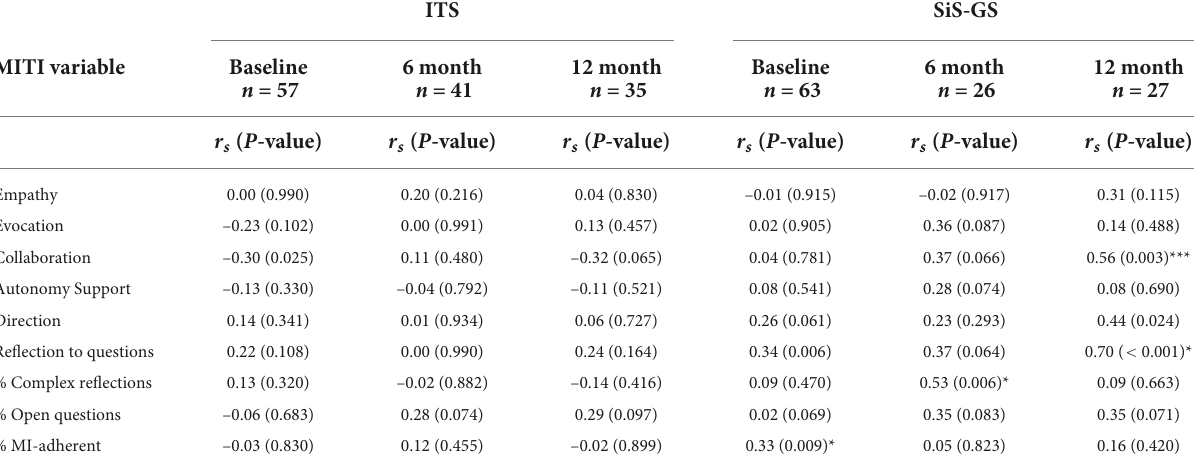
TABLE 3 Correlations between the MITI proficiency measures and the practitioners’ self-assessment (i.e., the CEQ-scores) at the three assessment